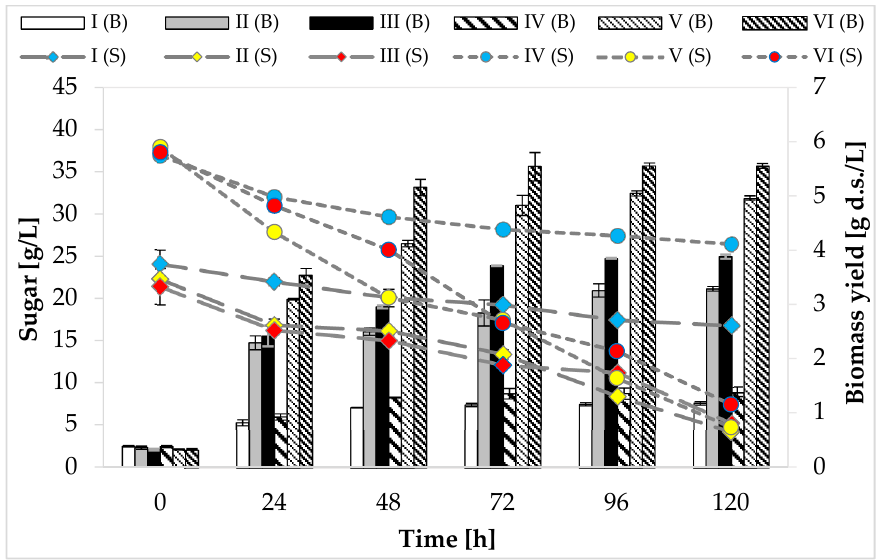
Figure 1. Consumption of carbon sources and growth of P. freudenreichii T82 strain. Reducing sugars (glucose and fructose) were included in the graph; sucrose consumption was not taken into account, because the tested strain does not assimilate and does not ferment this disaccharide/the sucrose content in individual media: (g/100 mL): I—0.08 ± 0.02; II—0.09 ± 0.01; III—0.07 ± 0.00; IV—0.15 ± 0.02; V—0.16 ± 0.03; VI—0.15 ± 0.01.